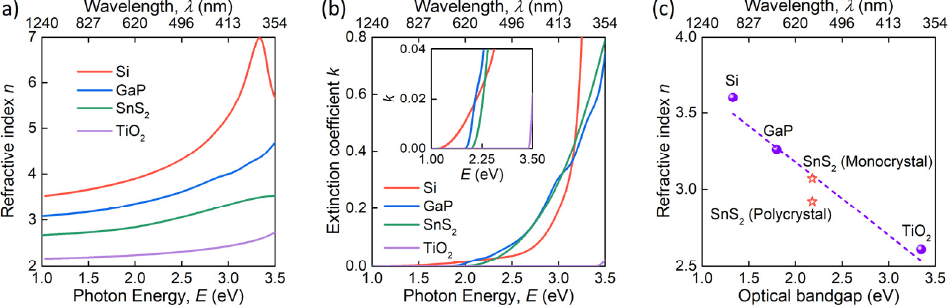
Figure 6. SnS 2 as a high refractive index material. ( a ) Refractive index n and ( b ) extinction coefficient k of SnS 2 compared with other high refractive index materials—Si, GaP, and TiO 2 . ( c ) The dependence of refractive index and optical bandgap for high refractive index materials.